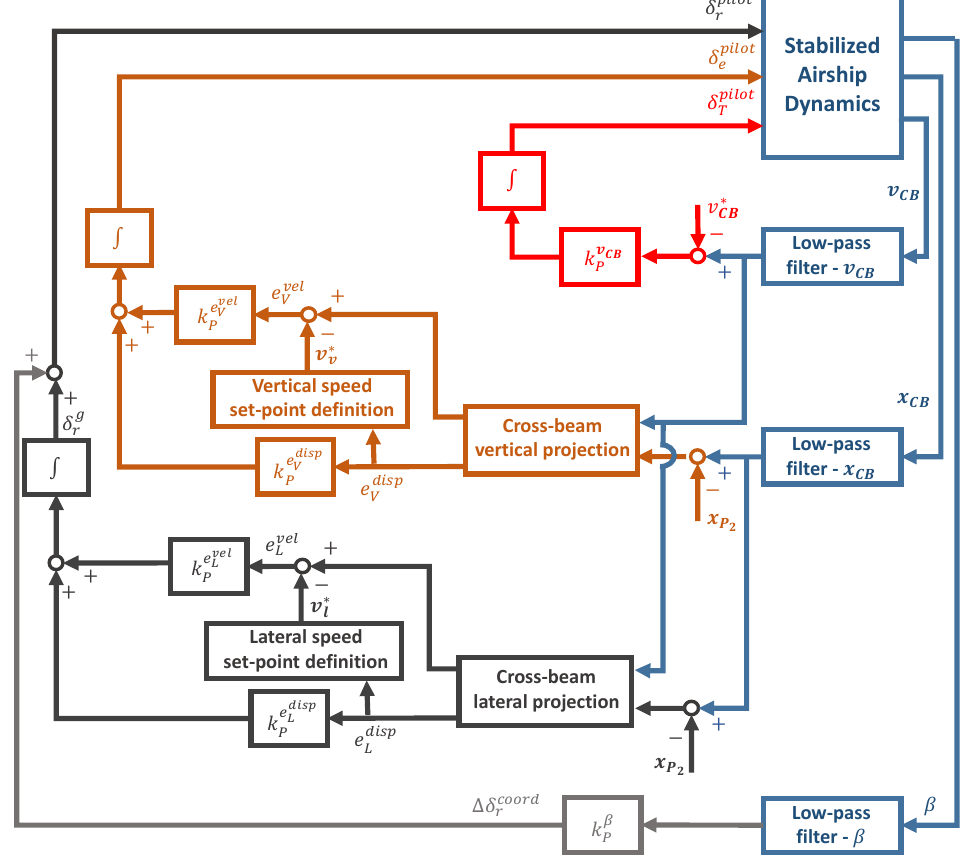
Figure 6. Proposed guidance control for the baseline airship with deflectable aerodynamic surfaces and a single thruster. Red: airspeed tracking. Brown: longitudinal beam-tracking. Grey: lateral beam-tracking with turn